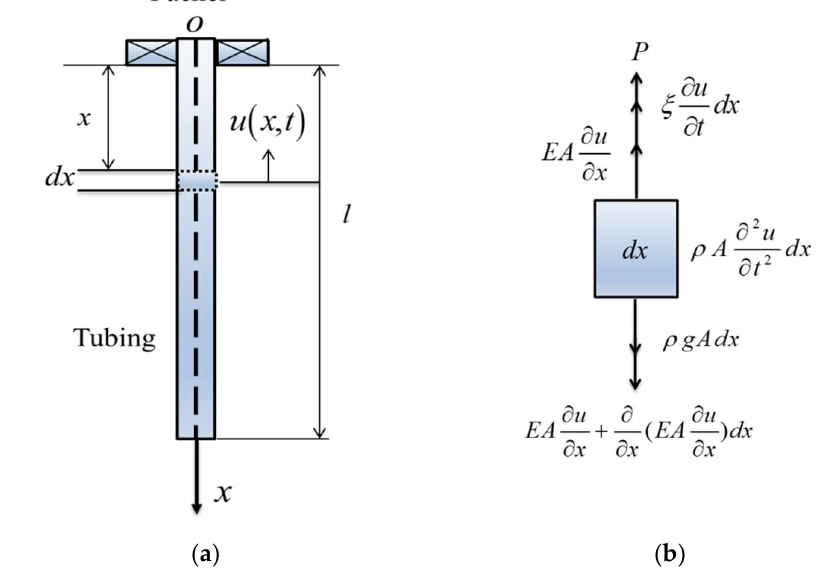
Figure 3. Simplified physical model of perforated string: ( a ) sketch of mechanical analysis; ( b ) mechanical model of perforated string under axial shock loads.